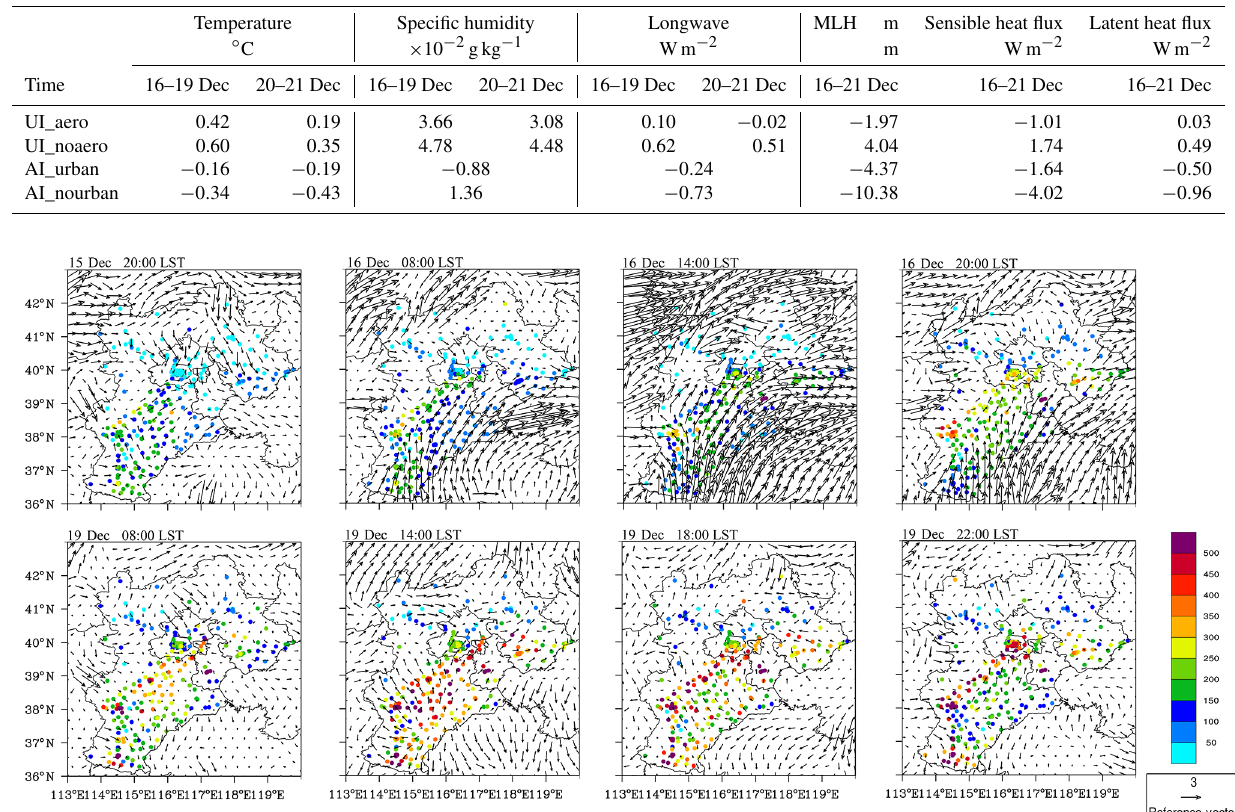
Figure 7. Spatial distribution of the observed concentration of PM 2 . 5 (dots; µgm − 3 ) and wind field (vector;ms − 1 ) for two increasing processes of the concentration of PM 2 . 5